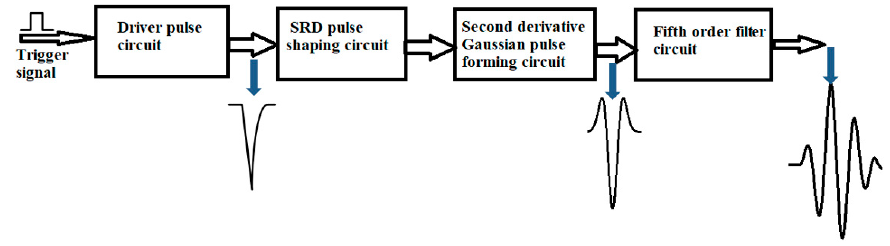
Figure 15 . Block diagram of the seventh Gaussian derivative pulse generator.